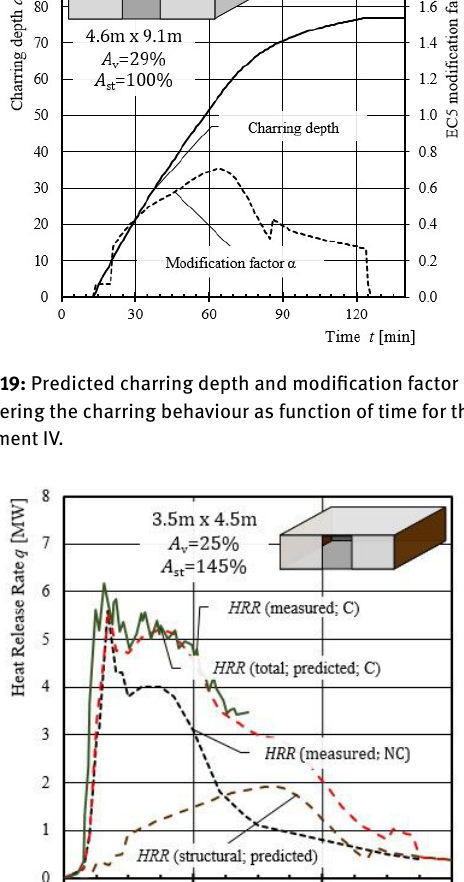
Figure 18: Predicted and measured temperatures for the predicted total HRR for experiment IV.